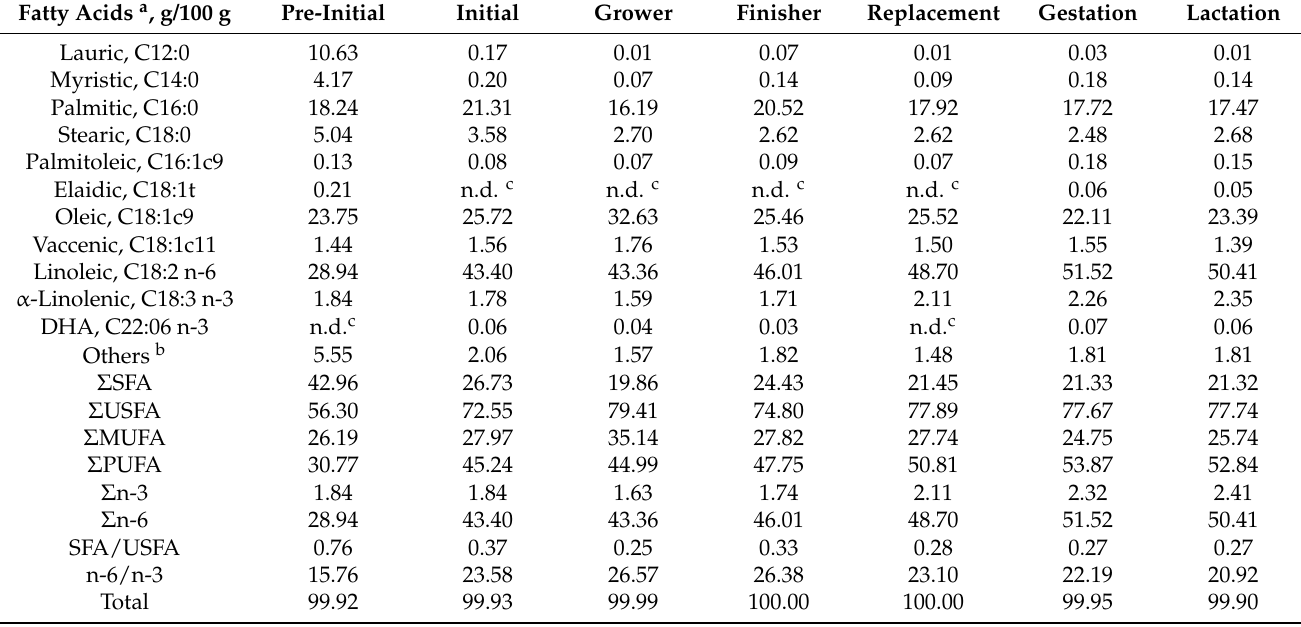
Table 3. Fatty acid composition and lipid fraction of diets offered to swine